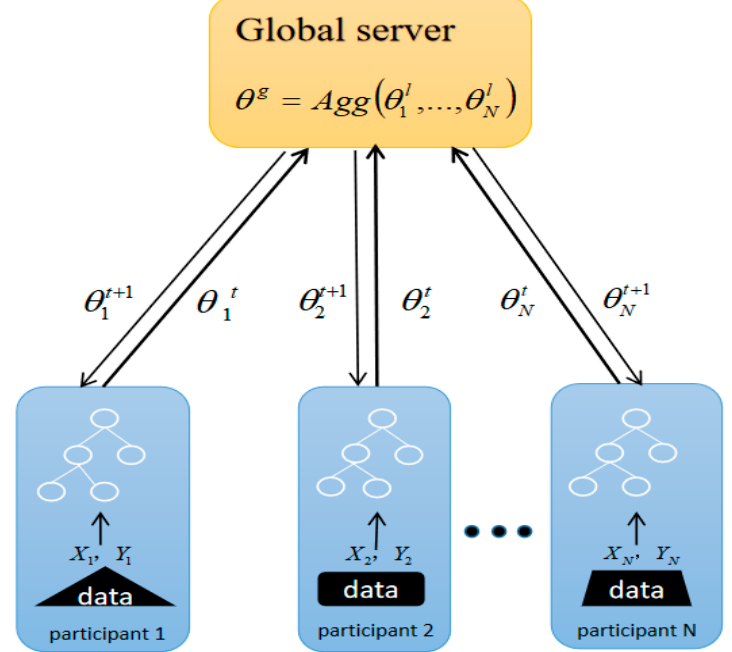
Figure 2. Horizontal federated learning for GBDTs.